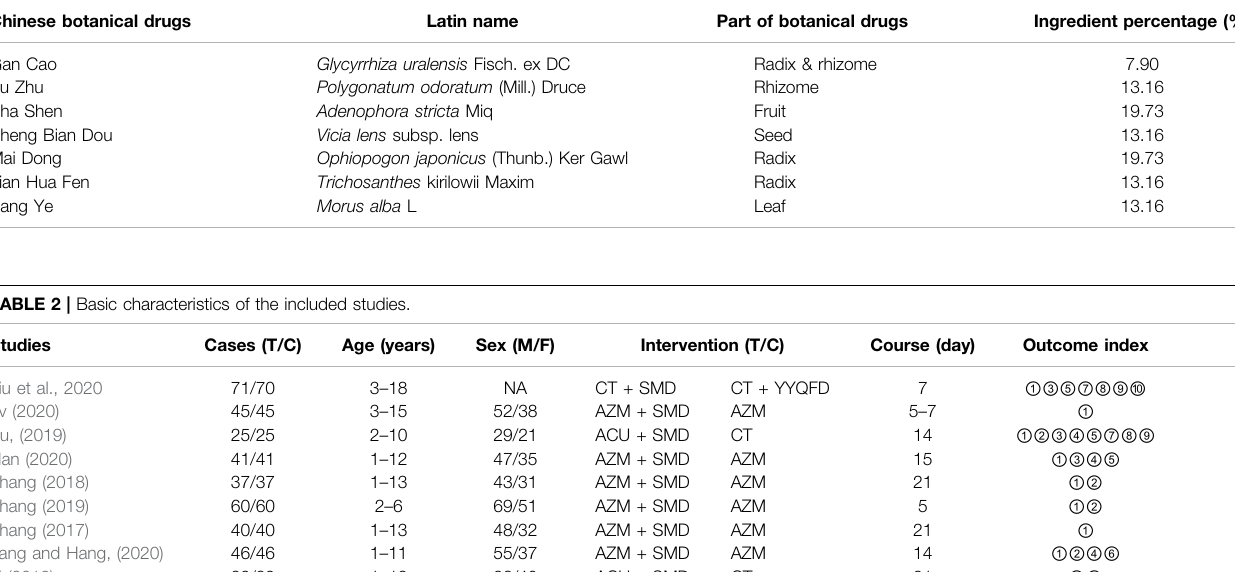
TABLE 1 | Ingredients and basic information of SMD.